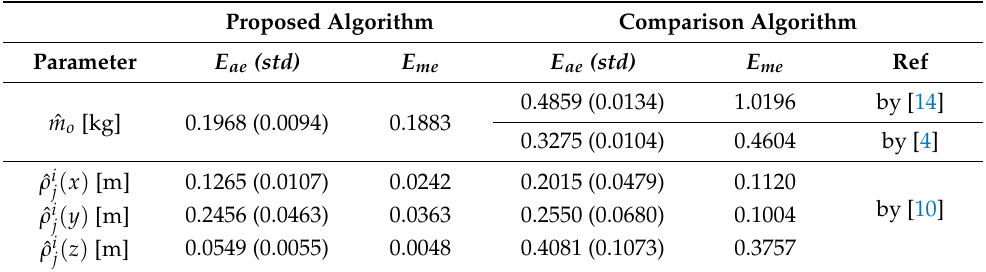
Table 2. Mass and kinematic parameter estimation performance. Proposed Algorithm Comparison